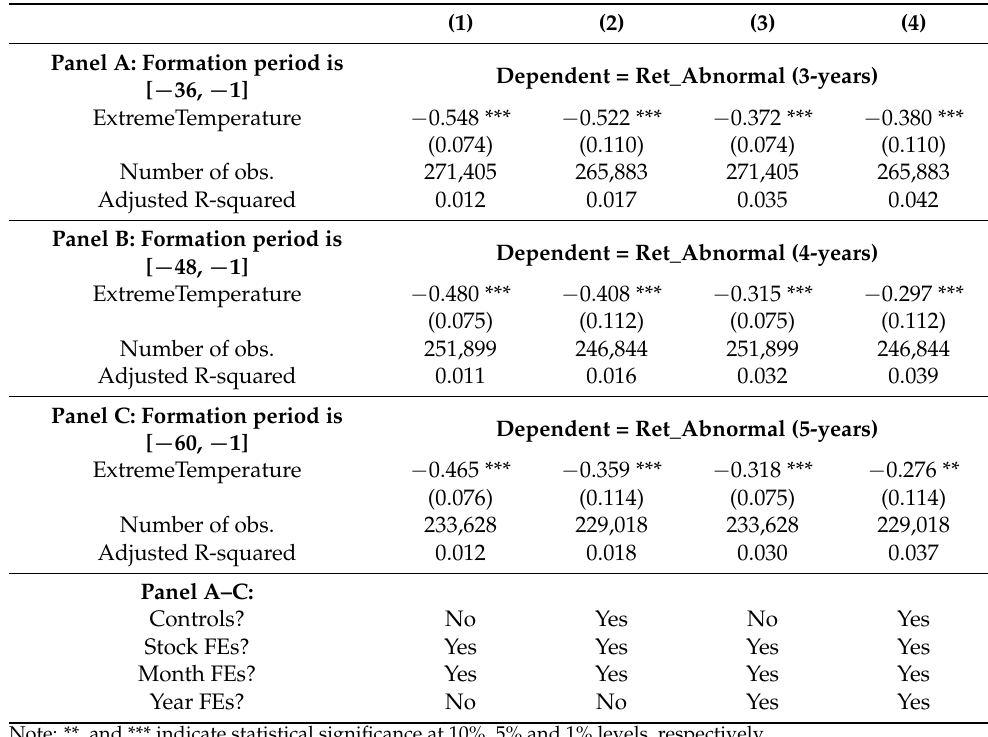
Table 13. Estimating expected returns by using alternative formation